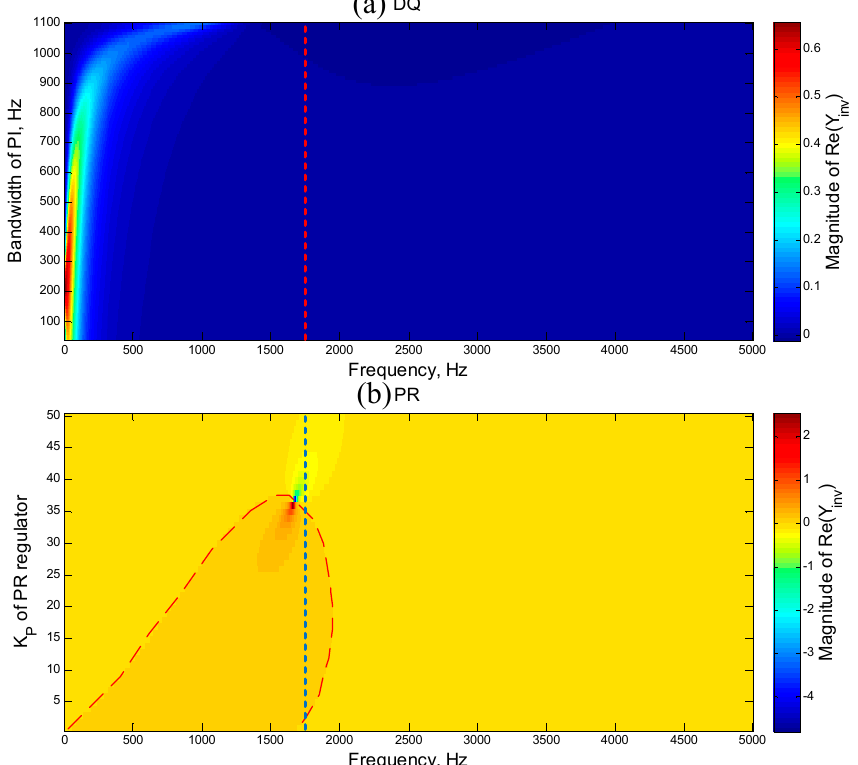
Figure 14. The influence from the current control parameters to Re{Yinv(j ω )}, full band. ( a ) dq-based control method; ( b ) PR-based control method.